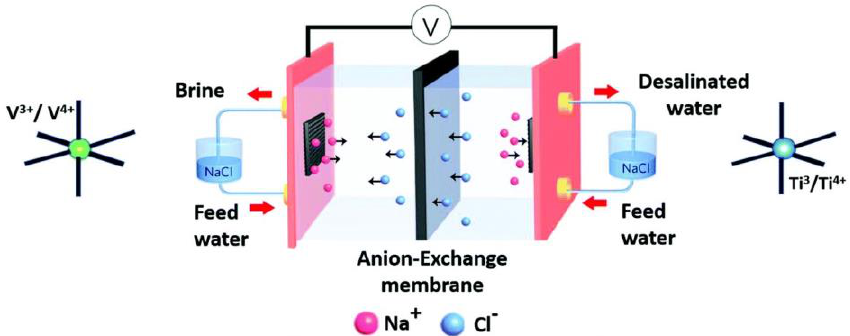
Figure 3. Illustration of the sodium ion desalination device. Reproduced with permission